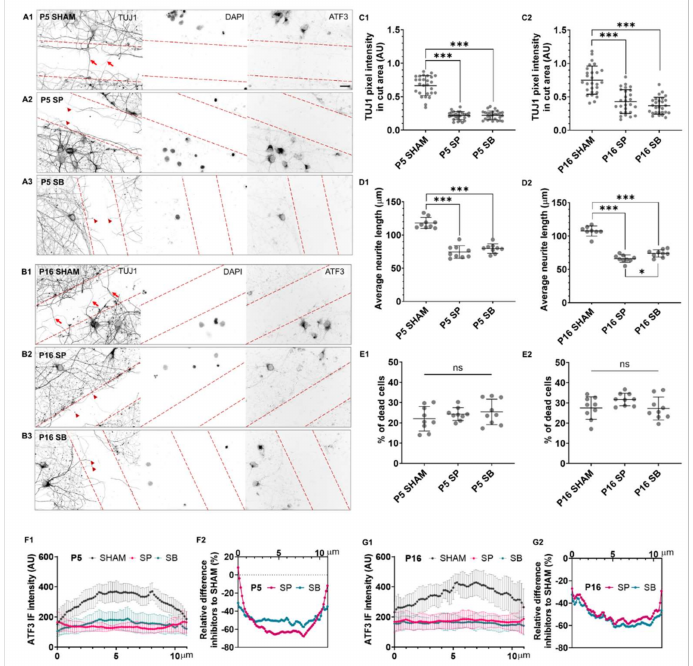
Figure 6. Reduction in neurite outgrowth by ATF3 inhibitors. Regrowth of TUJ1-positive neurites after scratch, with or without the presence of MAPK inhibitors SP600125 (SP, 50 µ M) and